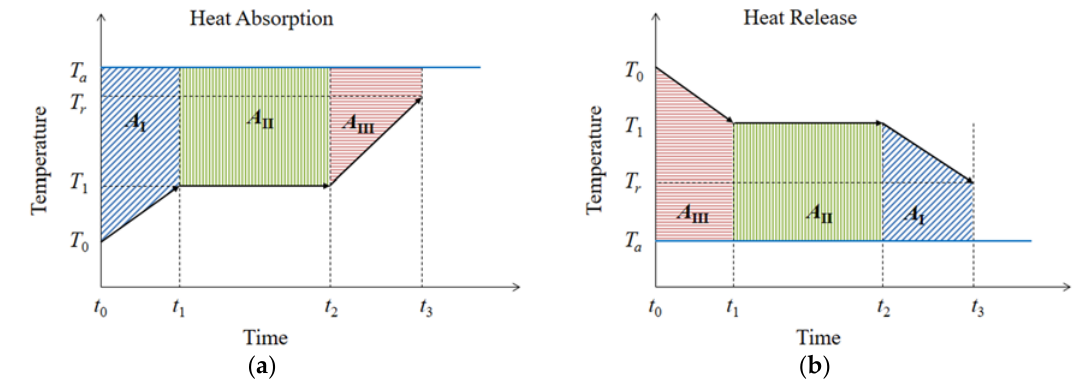
Figure 1. Illustration for: ( a ) The heat absorption and ( b ) the heat release of co_oil.